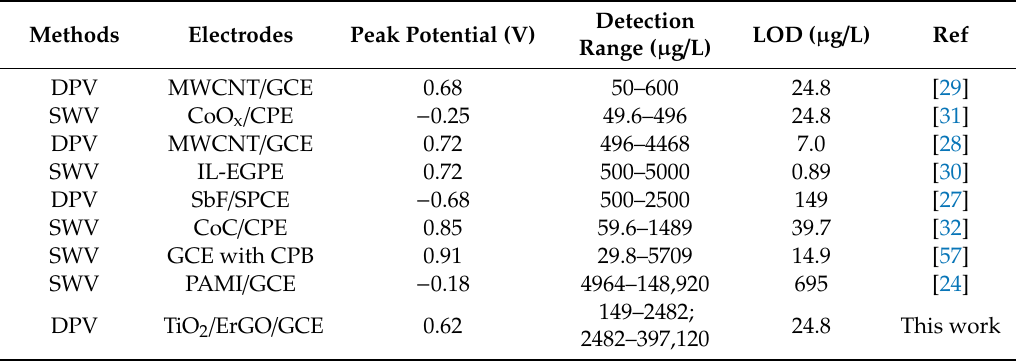
Figure 10. ( A ) DPV curves of Allura Red with various concentrations; ( B ) Linear plot of anodic peak currents of Allura Red versus their concentrations ranging from 0.3 to 5.0 μM; ( C ) Linear plot of anodic peak currents of Allura Red versus Napierian logarithm of their concentrations varying from 5.0 to 800 μM. Table 1. Comparison of electroanalytical methods for the determination of Allura Red. LOD: detection limit.